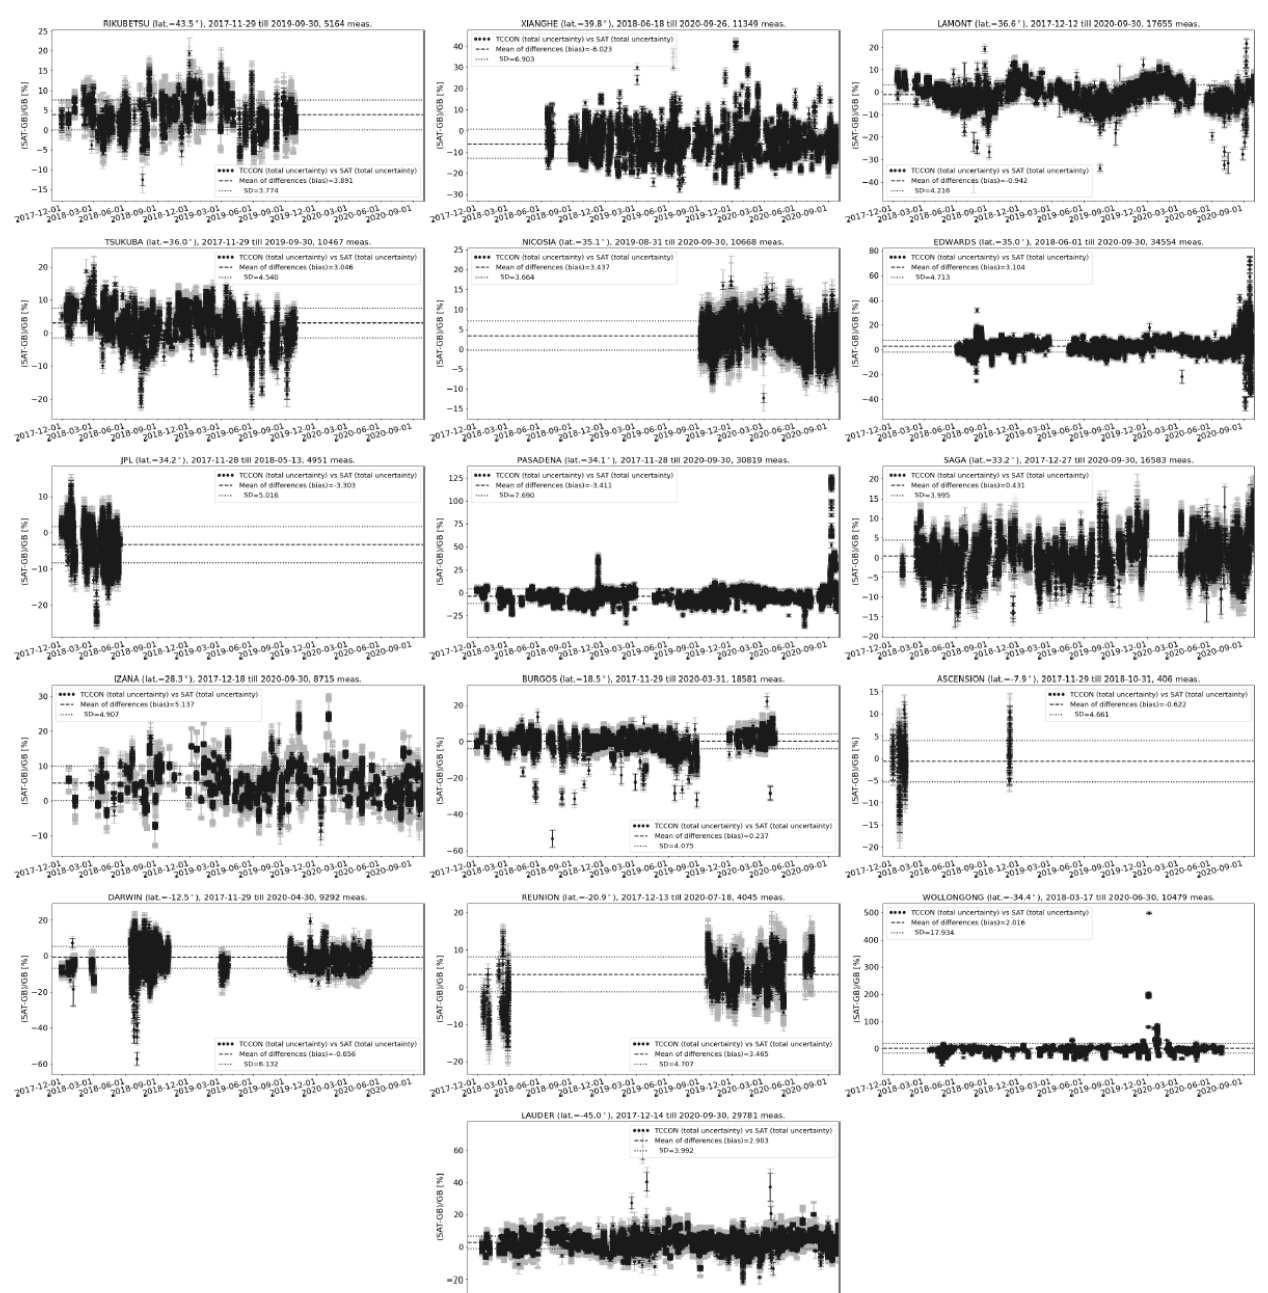
Figure 22. Same as Fig.